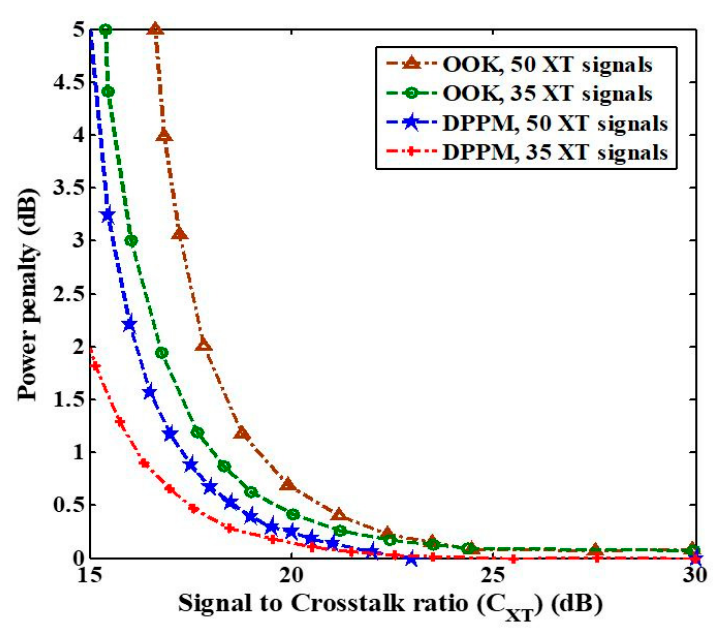
Figure 7. PP vs. C XT for OOK comparison with DPPM-M-PAPM at M = 2 and OOK/M-DPPM-M- PAPM at BER = 10 − 9 for XT (crosstalk) signals 35 and 50.